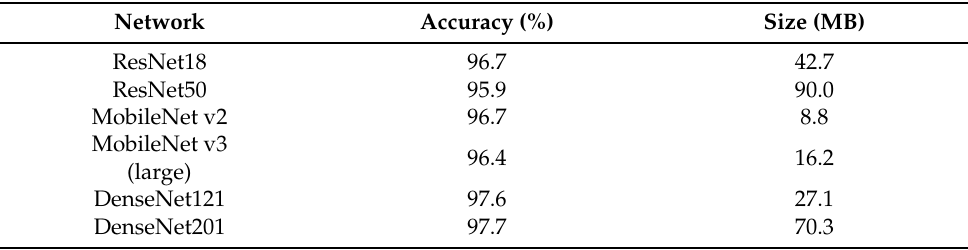
Table 7. The training results of each classification